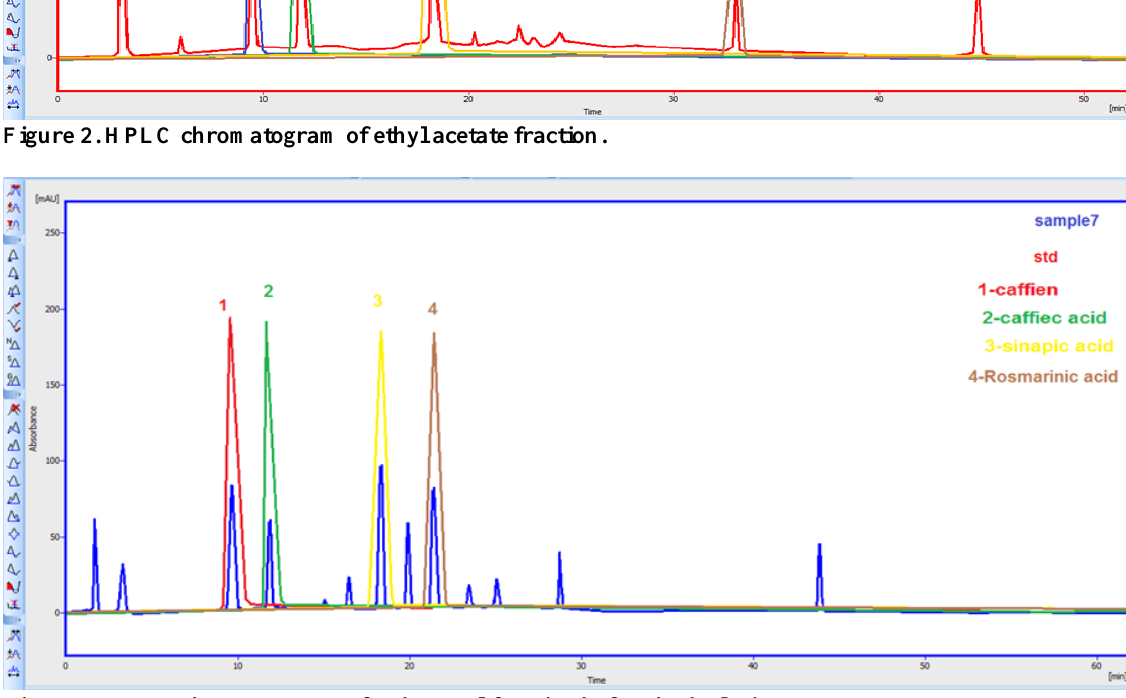
Figure 3. HPLC chromatogram of n- butanol fraction before hydrolysis